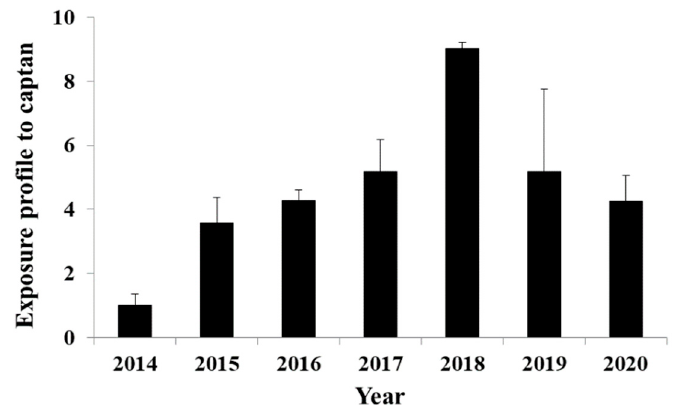
Figure 6. Captan exposure profile adjusted to 2014, back ‐ calculated from cis ‐ 1,2,3,6 ‐ tetrahydroph ‐ thalimide concentrations in influent wastewater collected in